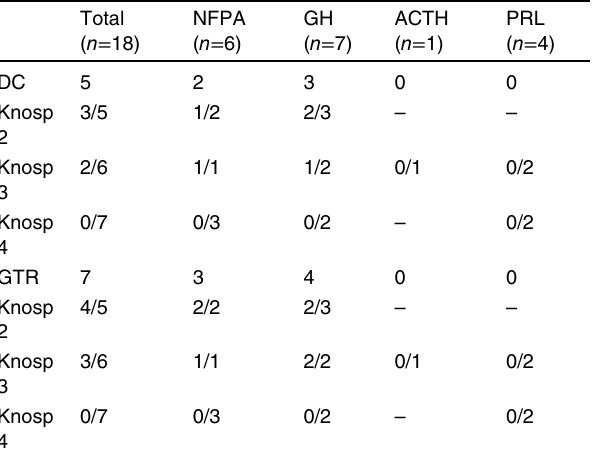
Table 6 Surgical outcome of pituitary adenomas with suprasellar extension Total ( n = 30)